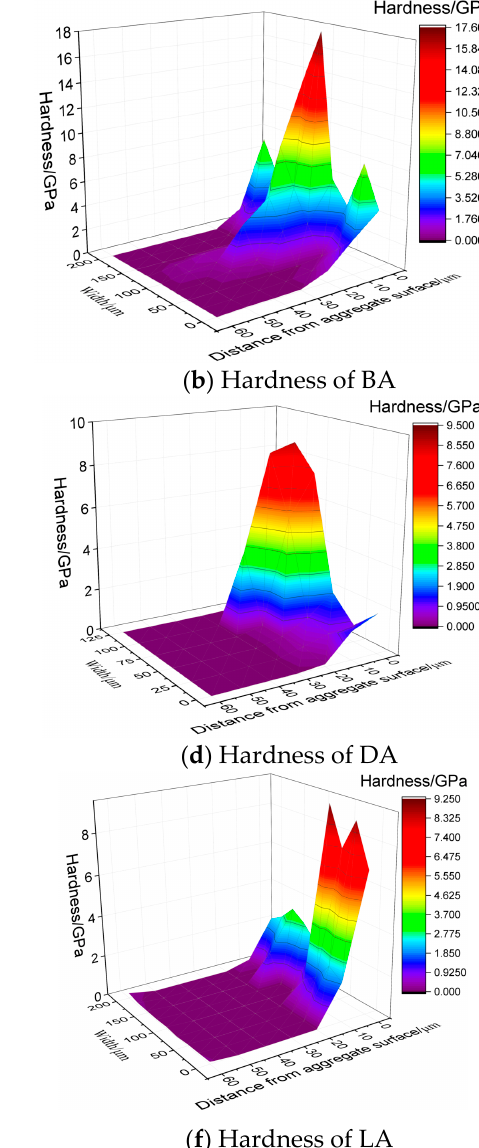
Figure 7. Modulus and hardness distribution of the interfacial zone. ( a ) and ( b ) BA, ( c ) and ( d ) DA, and ( e ) and ( f ) LA.